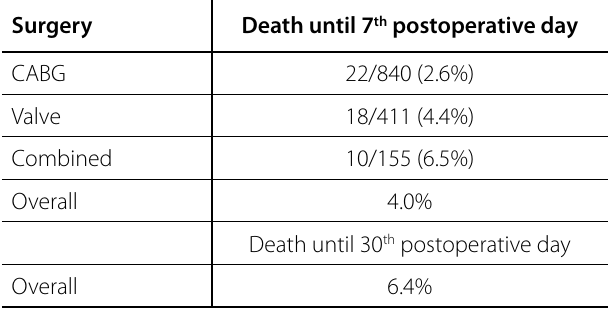
Table 5. Overall mortality and according to the procedure. Surgery Death until 7 th postoperative day CABG 22/840 (2.6%) Valve 18/411 (4.4%) Combined 10/155 (6.5%)